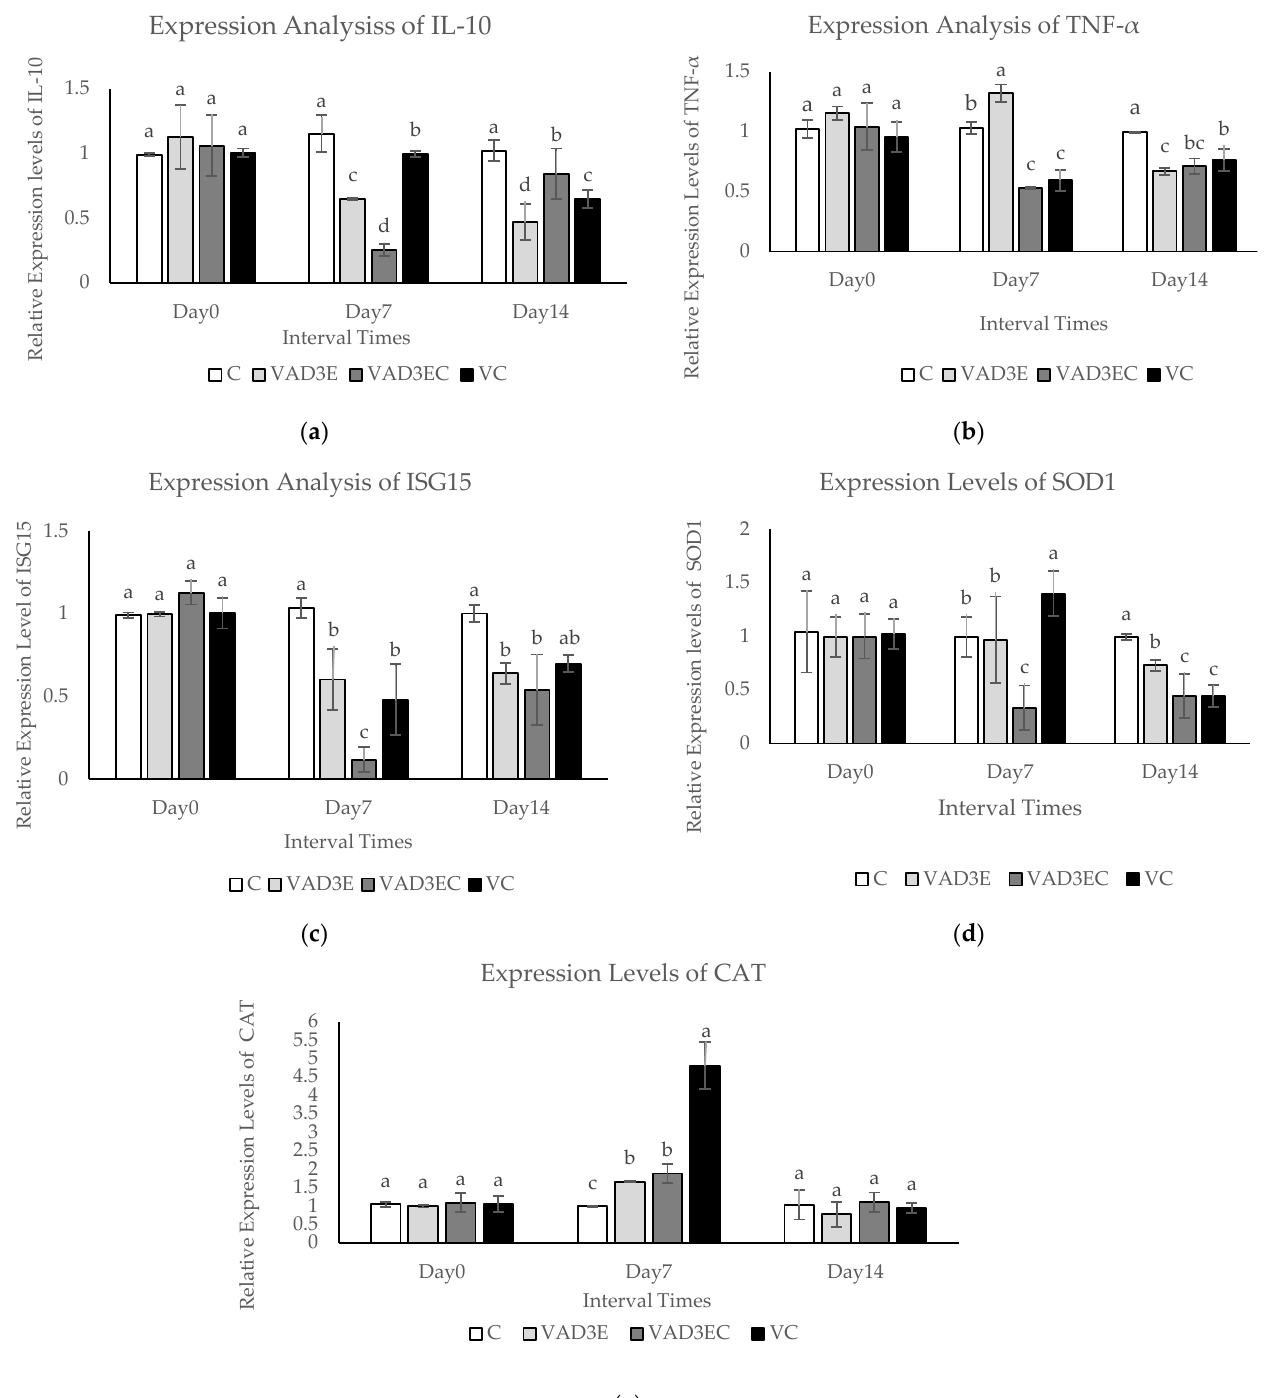
Figure 4. The mRNA expression levels in blood samples of dairy cows over 14 days with different treatments. ( a – e ) The mRNA expression levels of IL-10, INF- α, ISG15, SOD1 , and CAT in dairy cows with different treatments. Data are presented as means ± SE. Different lowercase letters above each bar indicate significant differences at the same time point ( p < 0.05). White filled bar: C; light gray filled bar: VAD3E; gray filled bar: VAD3EC; black filled bar: VC. C: the control treatment for which cows were injected with normal saline; VAD3E: cows injected with vitamin AD3E; VAD3EC: cows received both vitamins AD3E and C; VC: cows injected with vitamin C; Day 0: at 0 days (early interval time); Day 7: at 7 days (middle interval time); Day 14: at 14 days (late interval time).